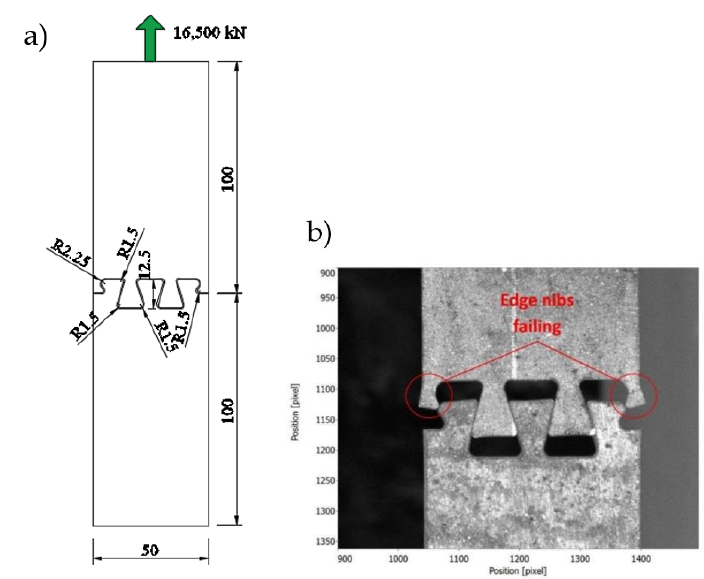
Figure 7. Front ISC: ( a ) geometry; ( b ) experimental deformed shape.